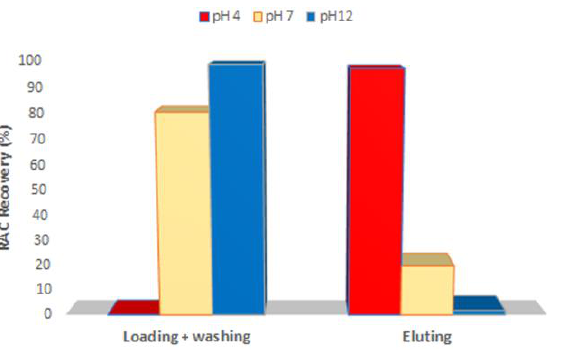
Figure 5. RAC recoveries obtained from RAC-MISPE using different pH of conditioning solvent.